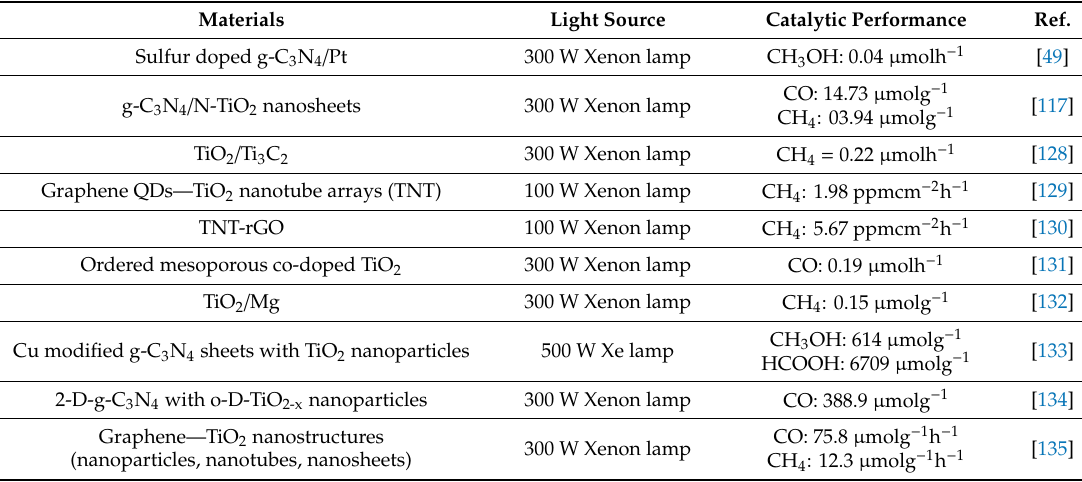
Table 5. Summary of the photochemical catalytic reduction performance of the various reported composite